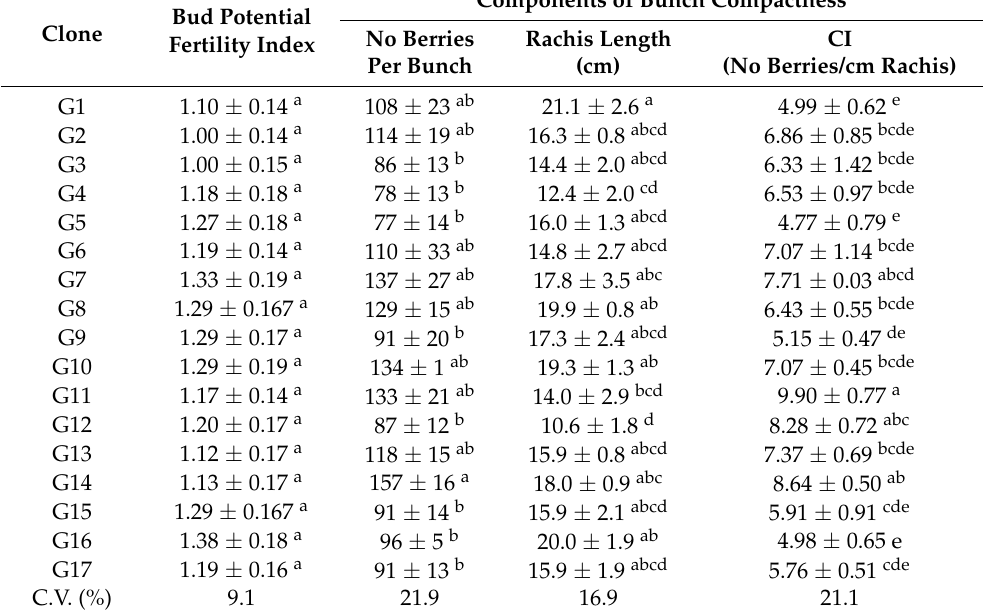
Table 1. Bud potential fertility and bunch morphological traits. In each column, different statistical letters indicate statistically significant groups according to a one-way ANOVA followed by Duncan post-hoc test ( p ≤ 0.05). The Coefficient of Variation (C.V.) among clones was reported for each measured parameter.